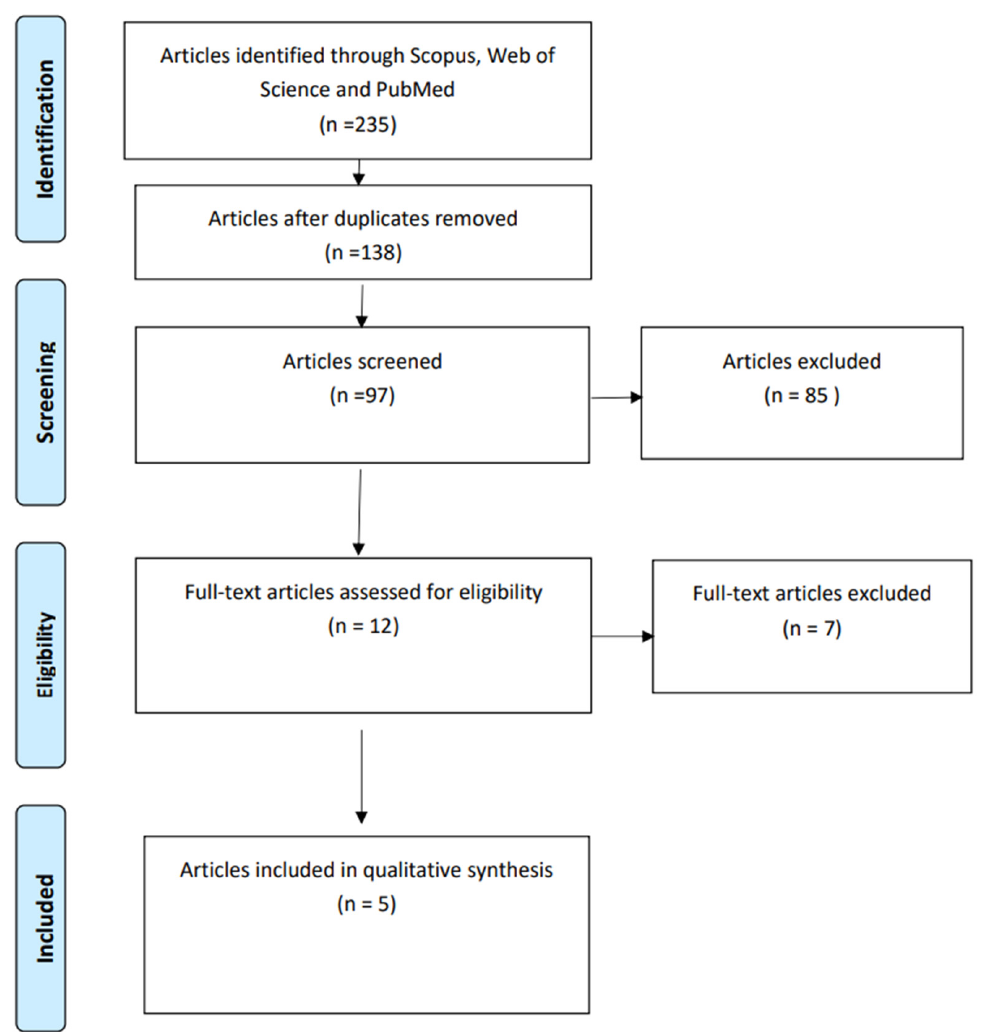
Figure 1. From: Moher, D.; Lberati, A.; Tetzlaff, J.; Altman, D.G. The PRISMA Group. Preferred Reporting Items for Systematic Reviews and Meta-Analyses: The PRISMA Statement. PLoS Med. 2009, 6(6), e1000097. doi:10.1371/journal.pmed1000097. [31]. For more information, visit www. prisma-statement.org (accessed 12 September